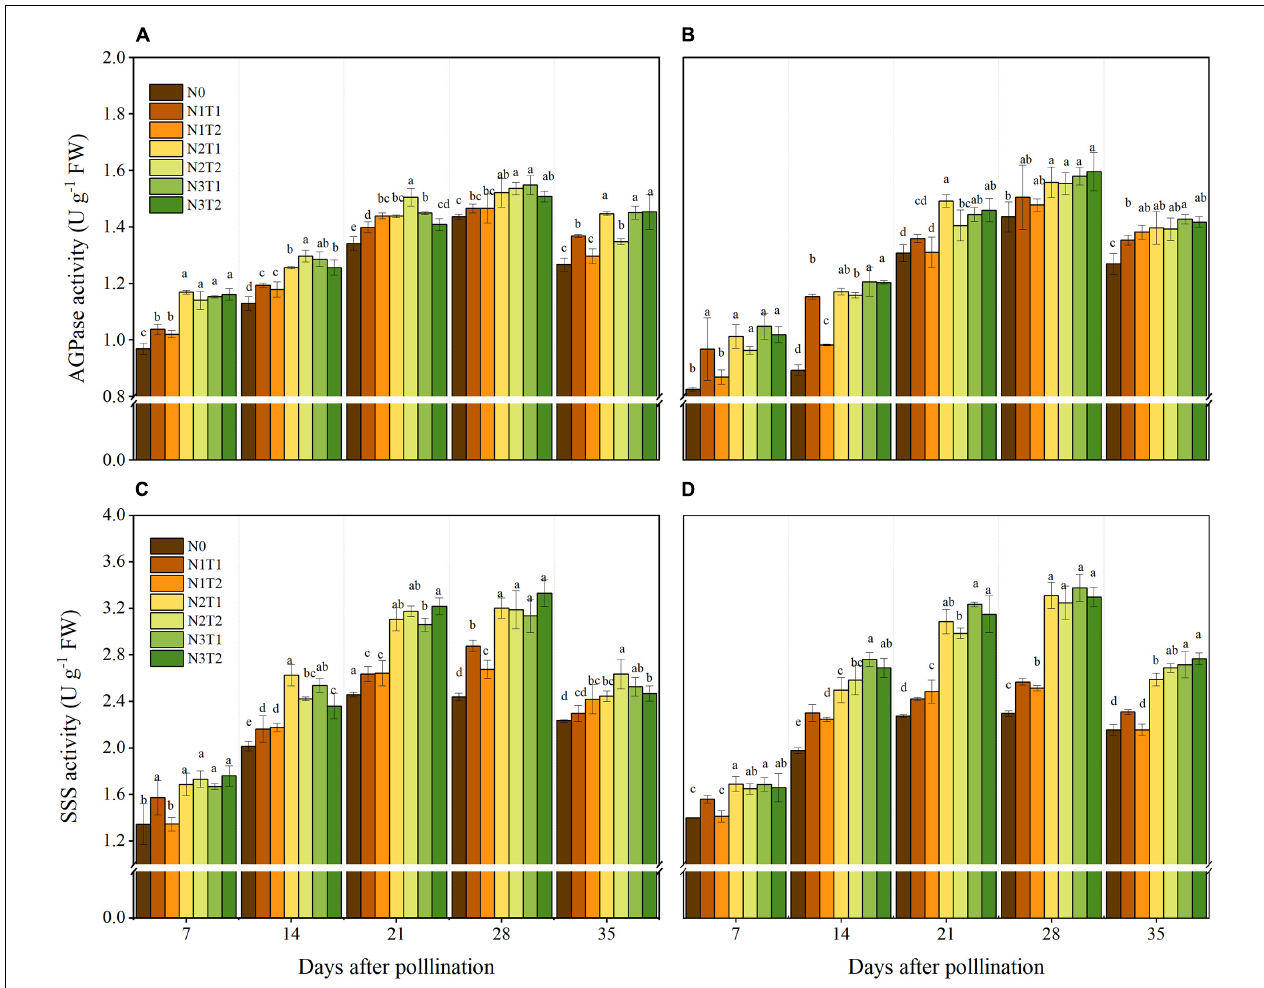
FIGURE 5 | Effects of N rate and time on the activities of AGPase and SSS in 2019 (A,C) and 2020 (B,D) . AGPase, ADP-glucose pyrophosphorylase, starch synthases. Different letters indicate significant differences at p < 0.05.